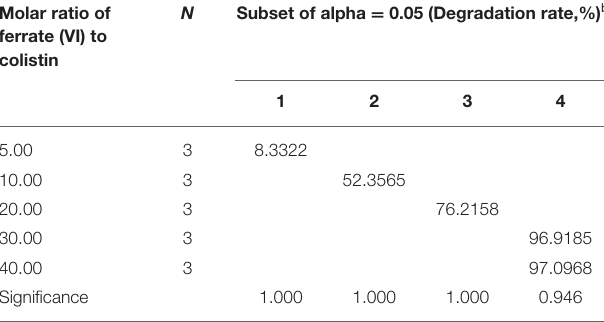
TABLE 2 | Analysis of variance on degradation of colistin by different molar ratio of ferrate (VI) to colistin a . Molar ratio of ferrate (VI) to